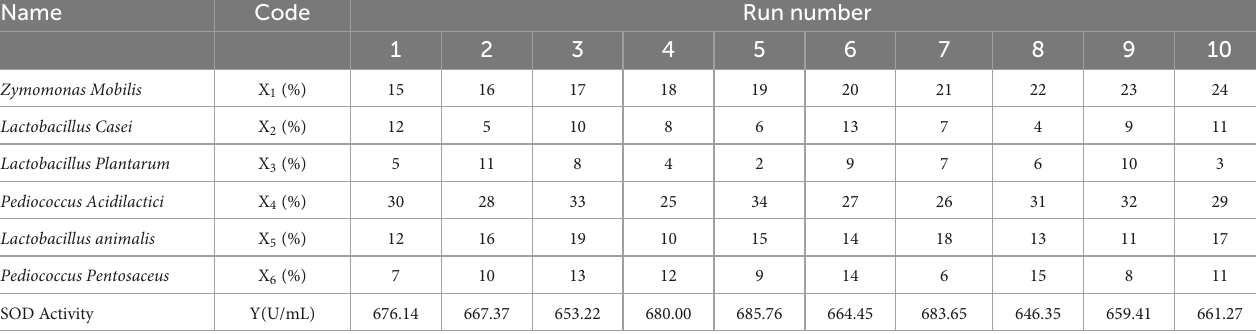
TABLE 6 Results of the uniform design